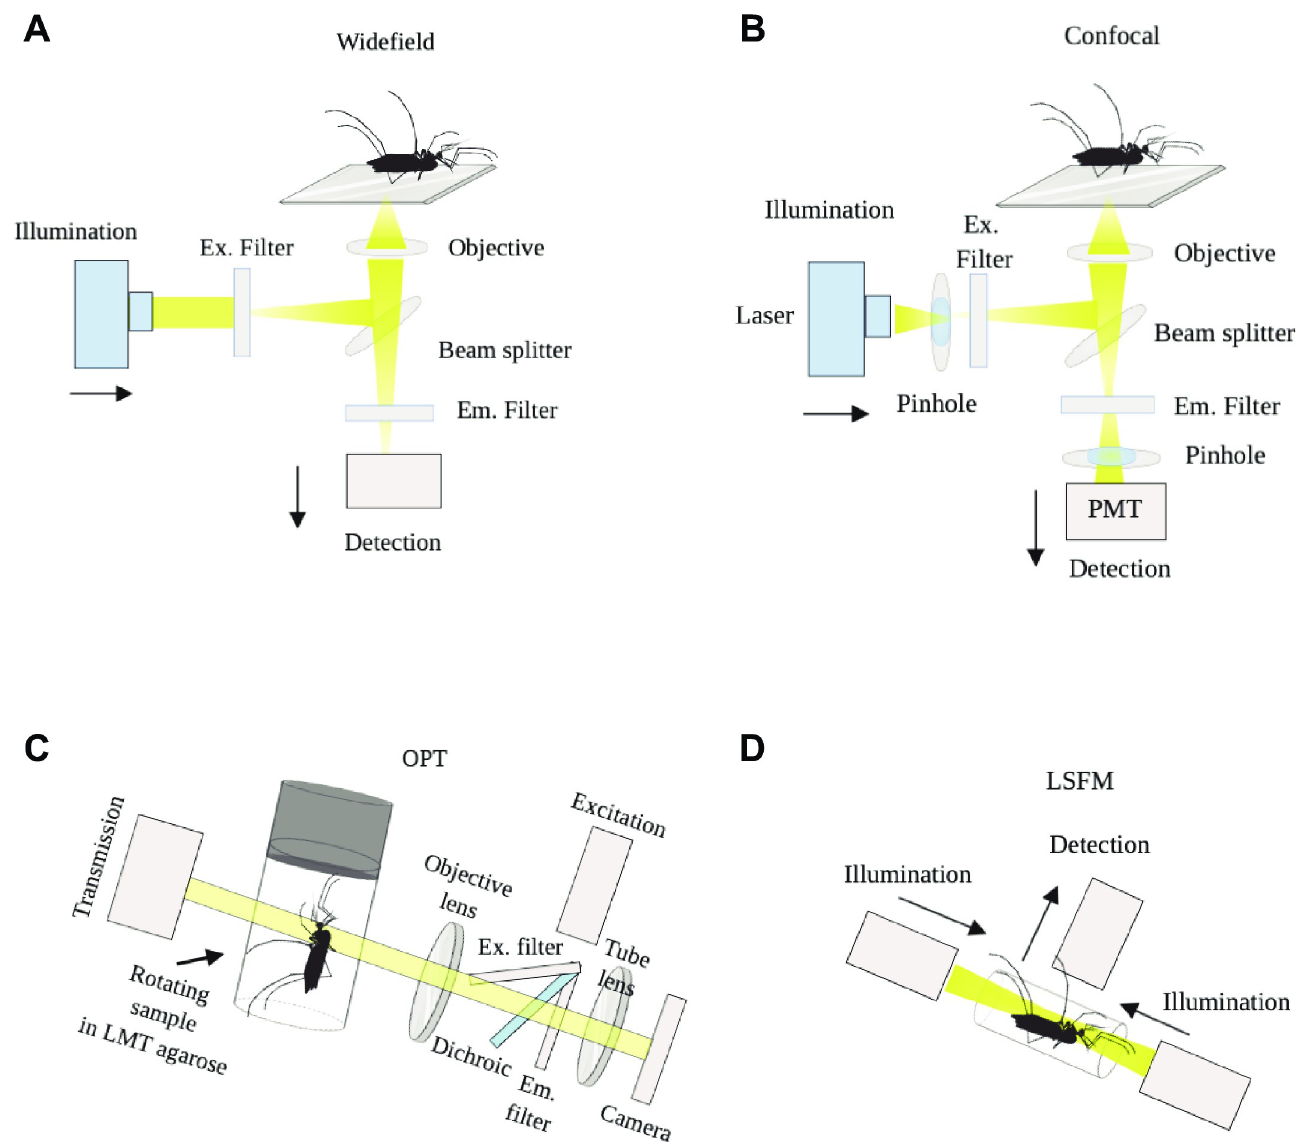
Fig 1. Microscopy methods used for imaging mosquitoes. A) ‘Inverted’ widefield microscopy: White light is filtered to the appropriate emission wavelength, and the emitted fluorescent light is projected onto a camera. B) Confocal microscopy: laser light is focused onto the specimen and a pinhole excludes out of focus light. Instead of a camera, photomultiplier tubes (PMTs) collect photons. C) Optical projection tomography: The optically cleared specimen is embedded in agarose, attached to a metallic cylinder within a rotating stage, and suspended in an index-matching liquid to reduce scattering and heterogeneities of refractive index throughout the specimen. Images are captured at distinct positions as the specimen is rotated. The axis of rotation is perpendicular to the optical axis, so that straight line projections going through the sample can be generated, and collected on the camera. D) Light sheet fluorescence microscopy: The sample is embedded in agarose, and suspended within a sample holder inside an index-matching liquid. A thin ( μ m range) slice of the sample is illuminated perpendicularly to the direction of observation. Scanning is performed using a plane of light, which allows very fast image acquisition. This figure was created using BioRender. com. Diagrams to generate this figure are republished from BioRender under a CC BY license, with permission from BioRender, original copyright (2020).